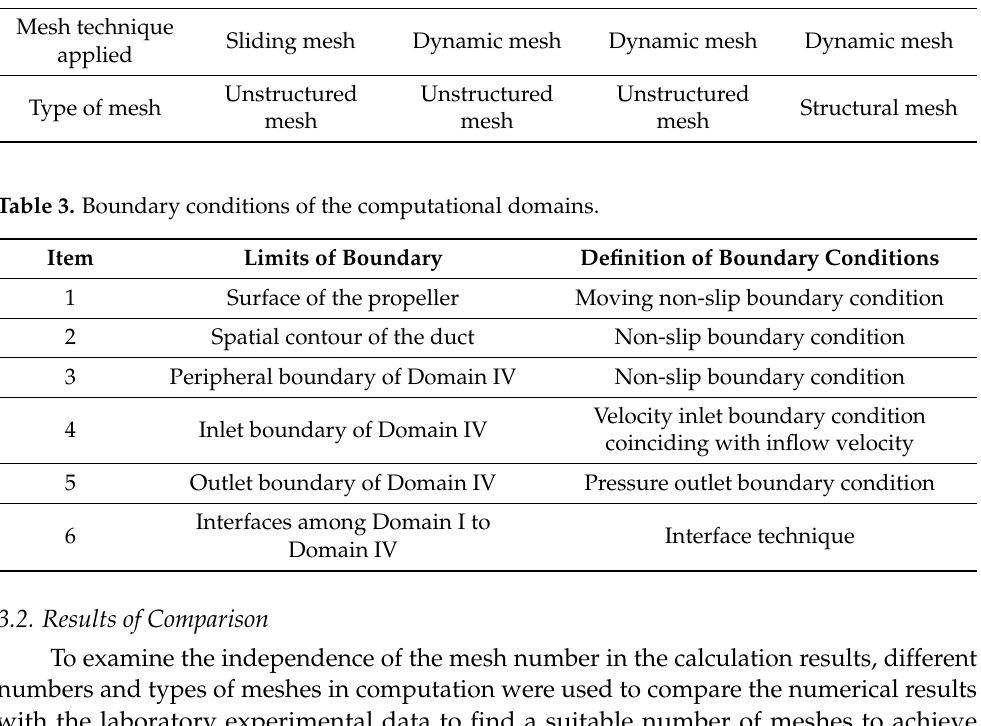
Table 4. Mesh information in the three cases.